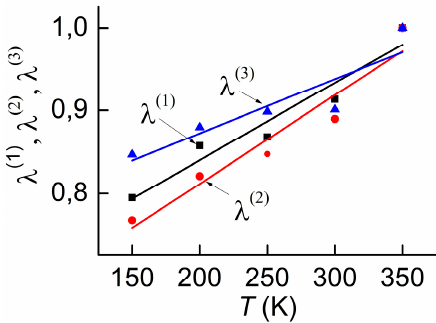
Figure 10. Temperature dependences of derivatives of magnetostriction coefficient on the magnetic field for a Ni layer. Solid lines represent the approximation of data by a straight line.